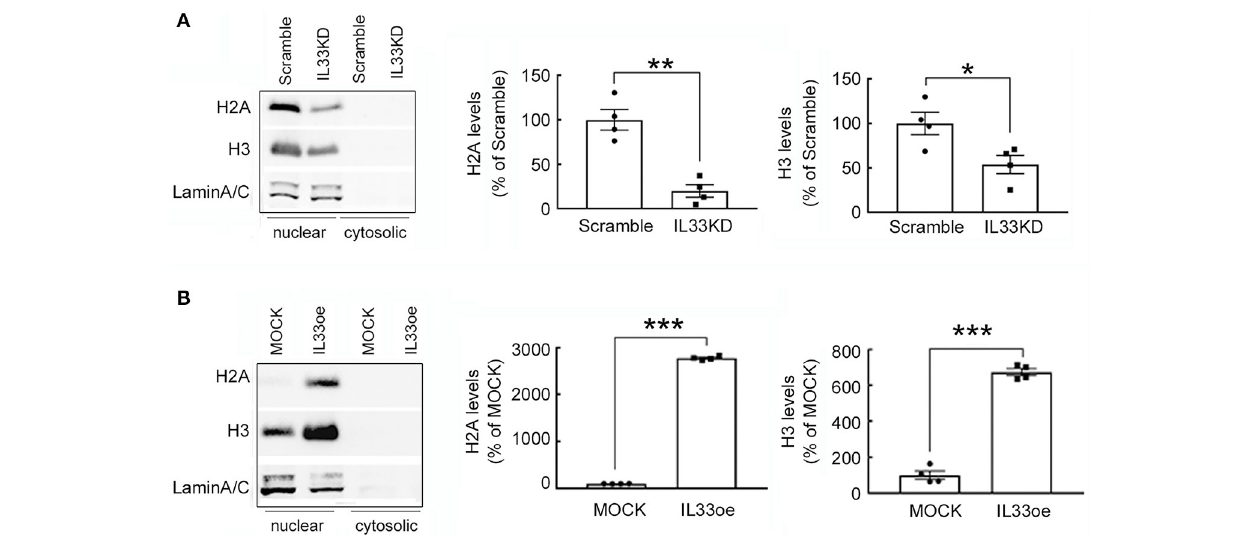
FIGURE 7 | H2A and H3 protein expression is regulated by IL-33 in human glioma cells. Nuclear proteins and cytosolic proteins were isolated from Scramble- and IL33KD-U251MG cells (A). Additionally, the protein samples were prepared from MOCK- and IL33oe-U251MG cells (B) . Western Blot analysis was conducted to measure the nuclear levels of H2A, H3, and Lamin A/C (as a loading control) in these transfectants. Representative images show the three proteins were only detected in the nuclear fraction. The nuclear levels of H2A and H3 in each immunoblot were quantified and normalized by the level of Lamin A/C. The results are presented as mean ± SEM from the four cell passages ( n = 4). * P < 0.05, ** P < 0.01, *** P < 0.001 vs. Scramble in (A) or MOCK in (B) . IL-33,